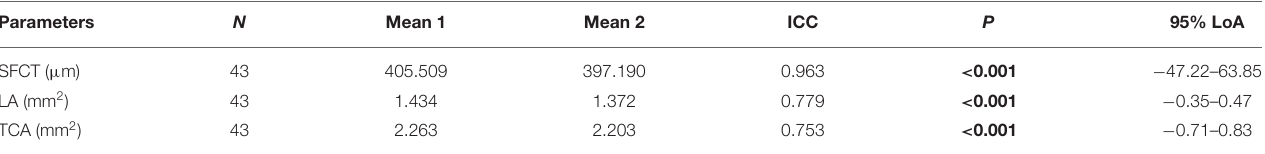
TABLE 5 | Reproducibility of the choroidal parameters in a random subset of eyes.